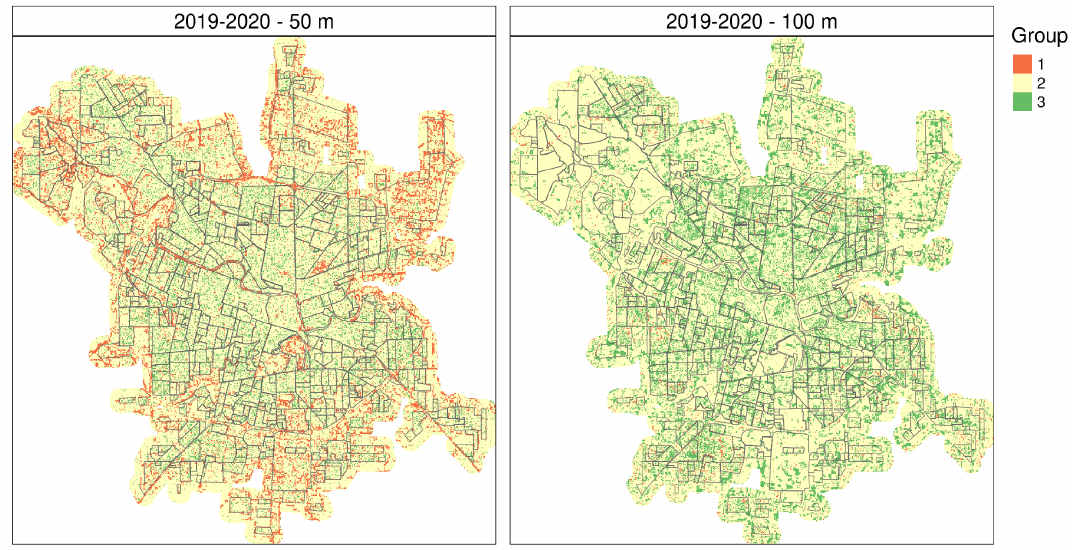
Figure 7. Distribution of temporal clusters for 2019–2020 based on the random forest models for 2018–2019 using remote sensing variables taken at 50- and 100-m radii. City of Córdoba, Argentina.